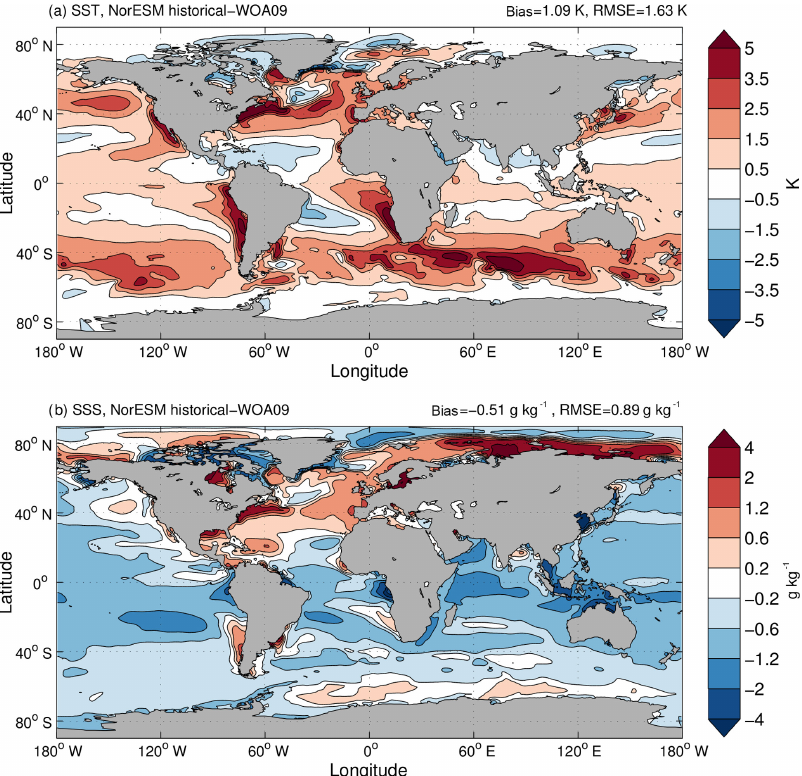
Figure 7. Simulated historical (a) SST and (b) SSS biases (model minus WOA09 data; model results are averaged between 1976 and 2005).